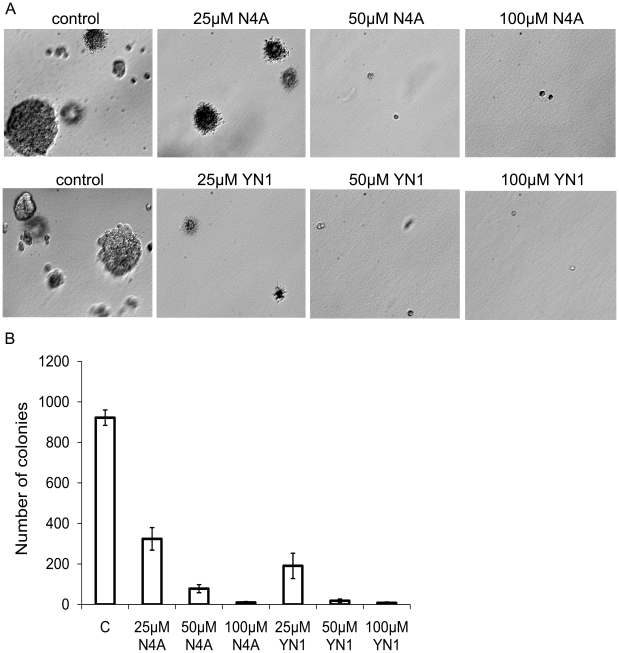
Treatment of HeLa cells with N4A and YN1 inhibits soft agar colony formation.(A) Anchorage-independent cell growth in soft agar. HeLa cells were grown in soft agar for 21 days in the presence of the indicated concentrations of N4A and YN1 respectively (20×). (B) Statistical analysis of the experiment. Columns, mean (n = 5); bars, SD.